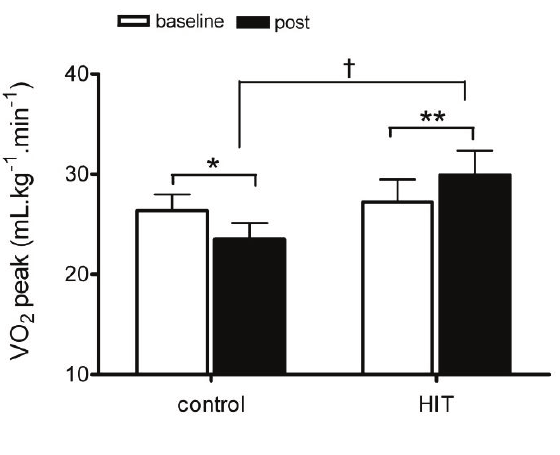
Figure 1. Change in VO peak for control and HIT pre and post intervention. * p < 0.05 2 pre to post within groups; ** p < 0.001 pre to post within groups; † p < 0.02 magnitude